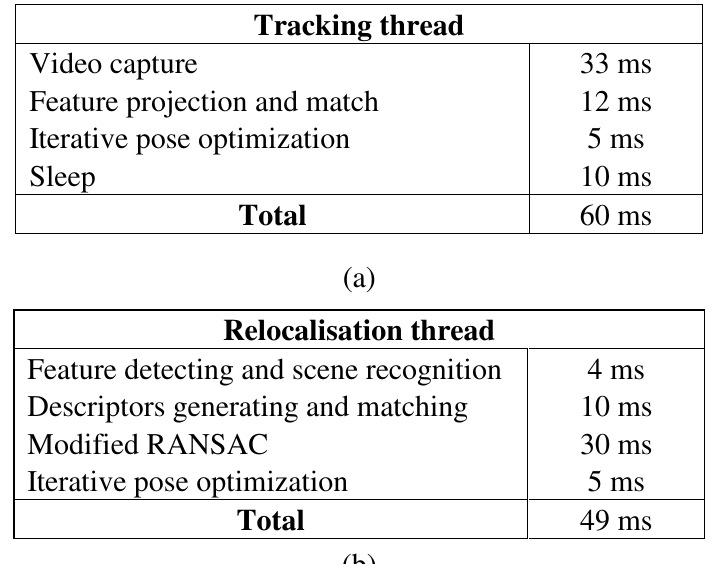
Table 1. Computational